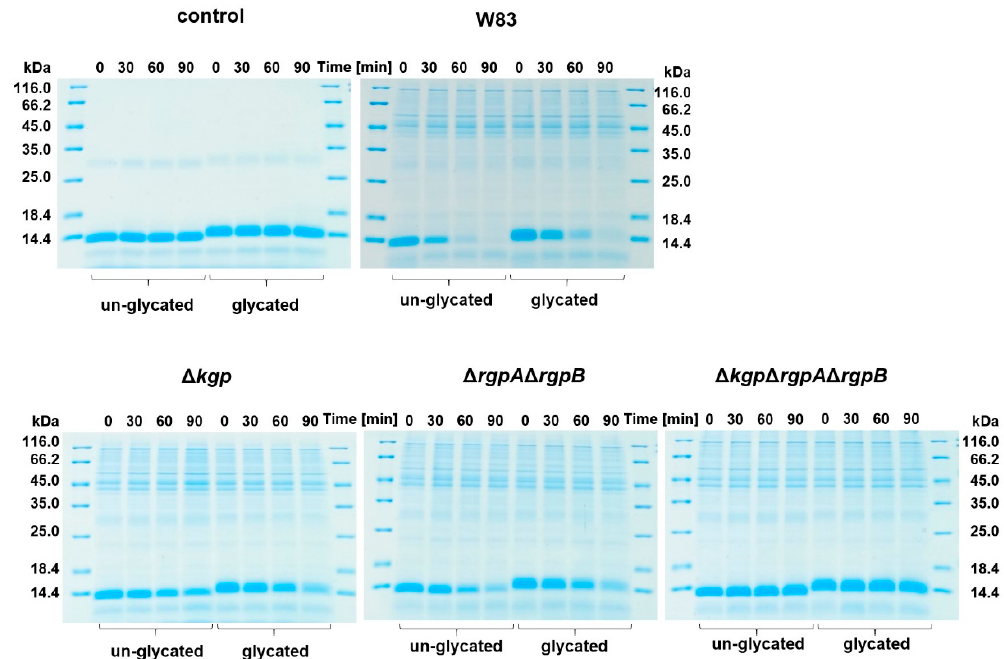
Figure 3. Susceptibility of hemoglobin to proteolytic activity of P. gingivalis . W83, wild-type P. gingivalis strain; Δ kgp , Δ rgpA Δ rgpB , Δ kgp Δ rgpA Δ rgpB , gingipain mutant strains lacking functional genes encoding lysine-specific Kgp and/or arginine-specific RgpA and RgpB, constructed in W83 strain.